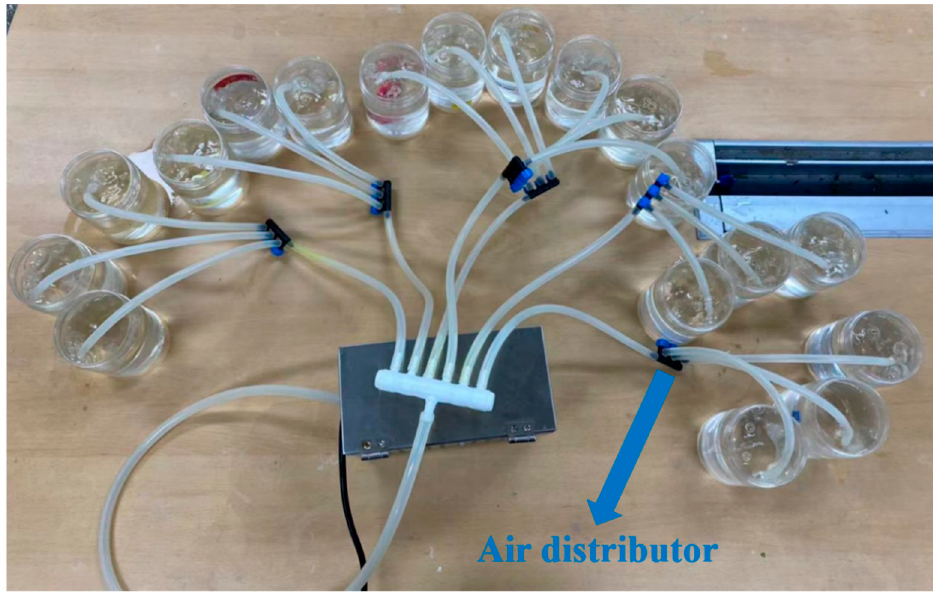
Figure 2. Distribution of the containers and species in the hydroponic system for one replicate. The air pump equally provides O 2 for the nutrient solutions via the air